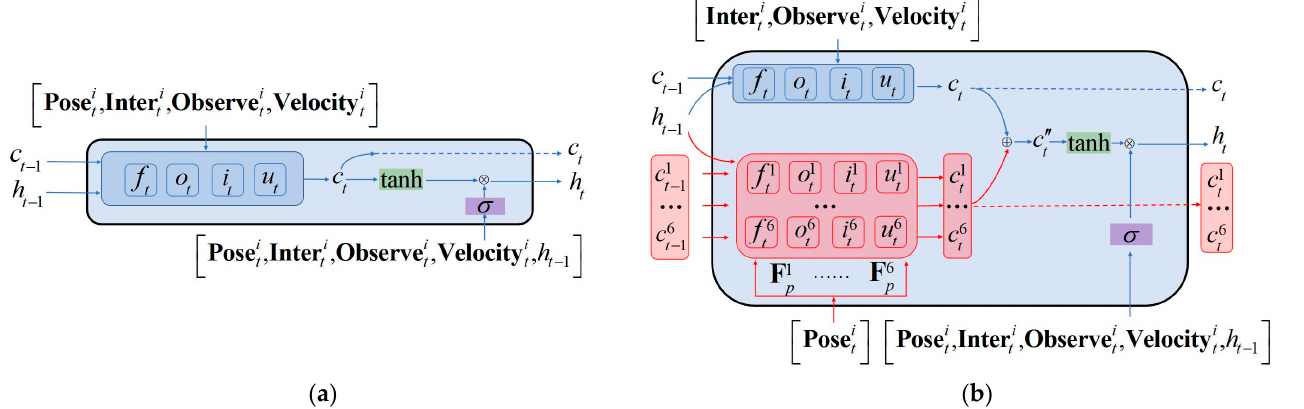
Figure 7. Schematic diagram of LSTM unit and feature-fusion LSTM unit: ( a ) LSTM unit and ( b ) feature-fusion LSTM unit.